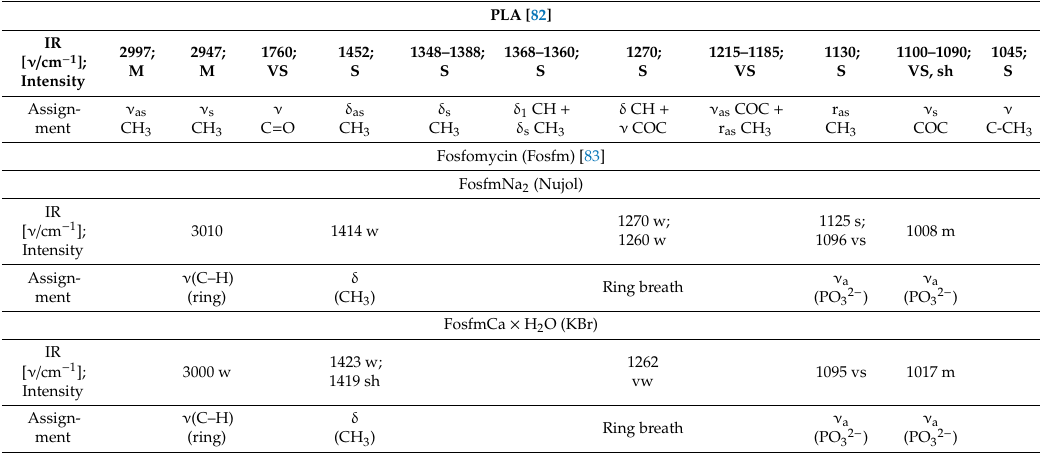
Table 4. Characteristic FTIR bands determined for fosfomycin (Fosfm), polylactide (PLA) and the fosfomycin–polylactide nonwoven hybrid (PLA / Fosfm). PLA [82]